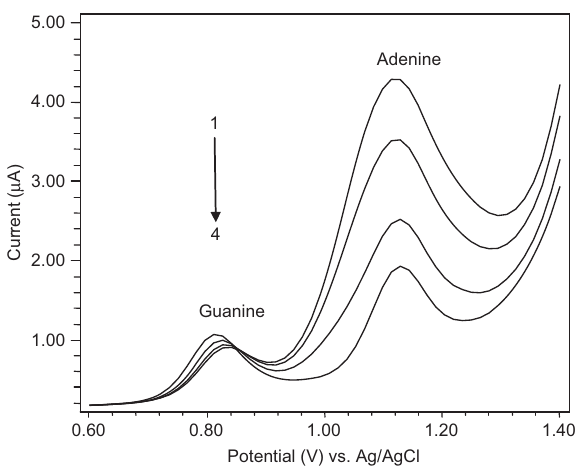
Figure 7 Differential pulse voltammogram of 4.23 × 10 -4 m of DNA in the absence (1) and presence of (2) 8.52 × 10 -5 m, (3) 1.70 × 10 -4 m , (4) 2.55 × 10 -4 m , gatifl oxacin in 0.2 m acetate buffer of pH 5.0 at multi-walled carbon nanotube paste electrode (MWCNTPE), pulse amplitude 50 mV, scan rate 50 mVs -1 , current range 10 μ A.